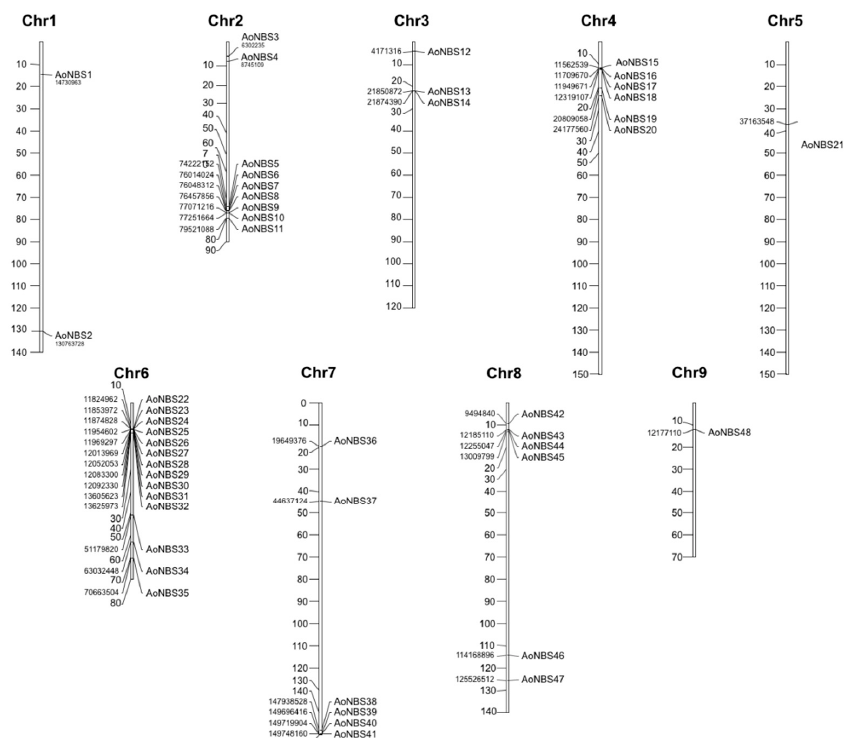
Figure 1. Chromosomal distribution of nucleotide binding sites (NBS) genes on the asparagus genome. Only those chromosomes bearing NBS genes are represented. The chromosome numbers are indicated at the top of each bar. The scale on the left of each chromosome is in megabases (Mb), whereas the coordinates for each locus are shown in base pairs (bp).